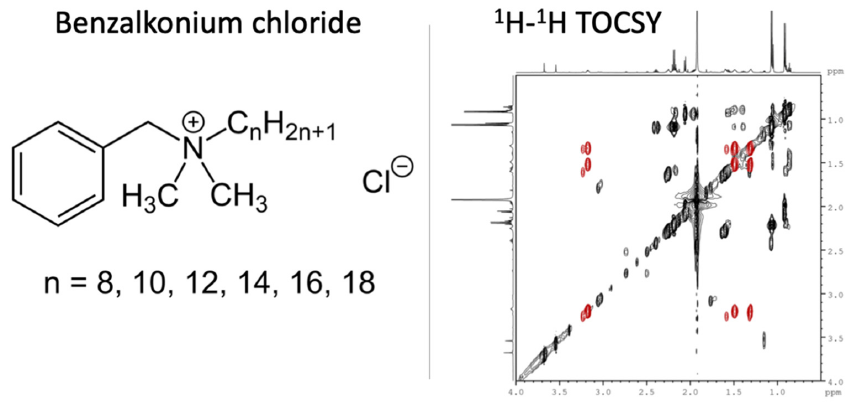
Figure 1. The chemical structure of benzalkonium chloride (BAC) shown alongside the 1 H- 1 H TOCSY NMR spectrum of a microcosm after 18 days of exposure to 16.7 mg/L BAC. The resonances from BAC are highlighted in red and were confirmed using a prepared standard.